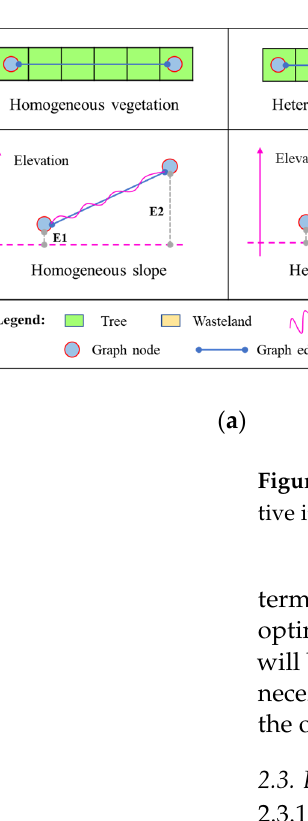
Figure 2. IGN initialization .